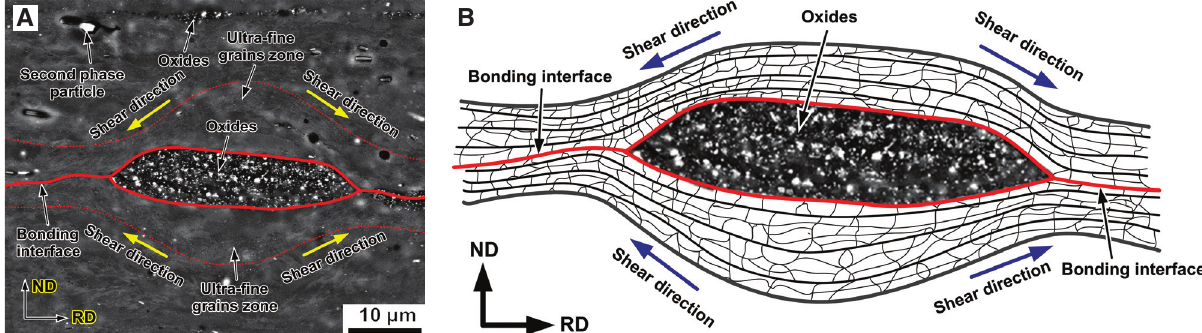
Figure 3 Shear bands and grain distortions around the oxides. (A) SEM-BSE larger magnification showing shear bands and grain distor- tions around the oxides; (B) schematic diagram of grain refinement and shear bands around the oxides.